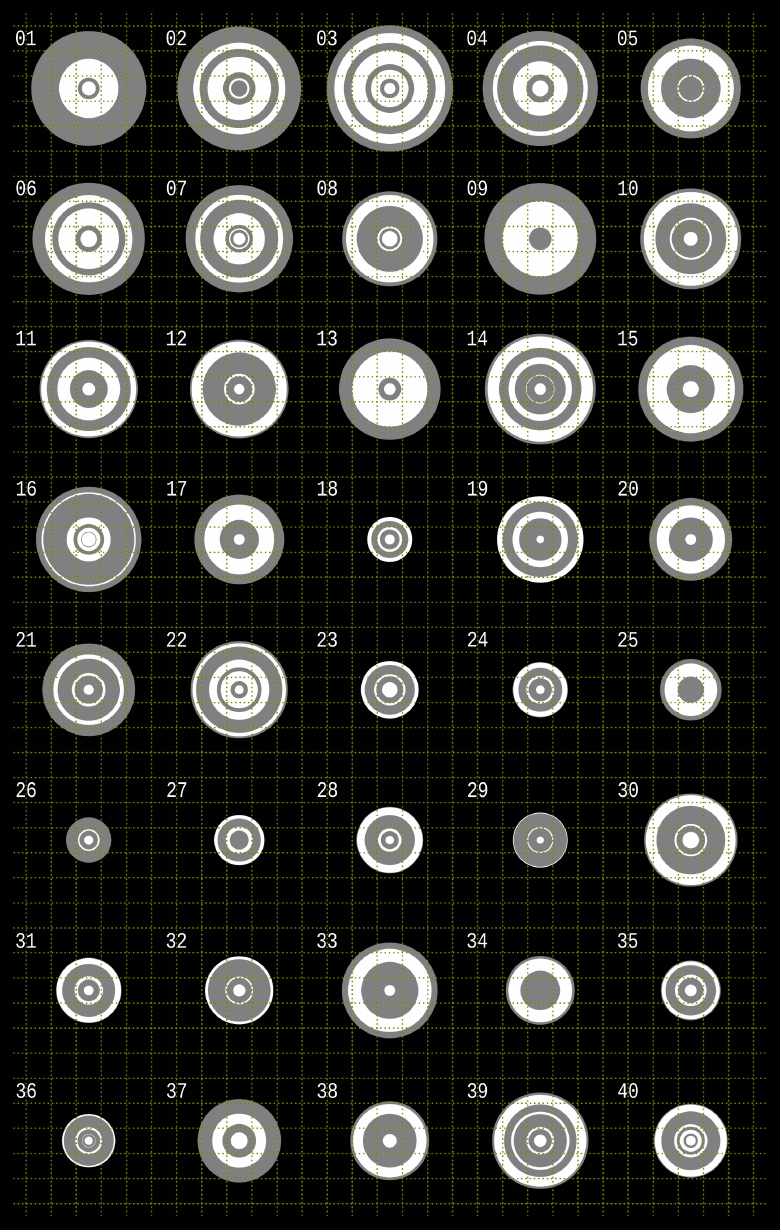
Figure 6. Equivalent circular hailstone cross sections generated from the layer analysis technique. White-shaded regions represents opaque dry-growth layers, and grey-shaded regions indicate translucent wet-growth layers. Grid lines shown at a 1cm spacing starting from 0.5cm from the embryo